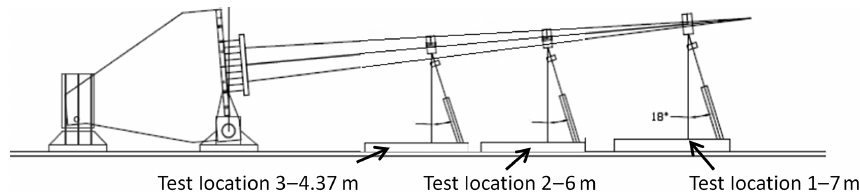
Figure 19. Representation of subscale blade test layout and testing locations.